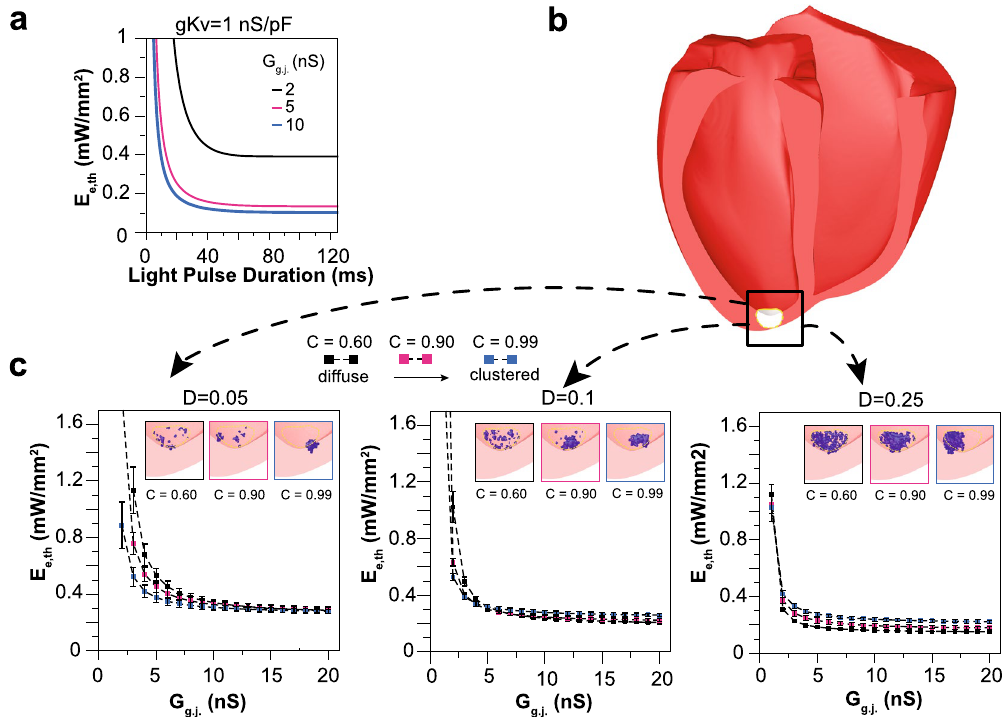
Figure 4. OptoGap applicability to arbitrary cell arrangements in the three-dimensional tissue setting. ( a ) Cellular model of a CM coupled to five ChR2-cFB indicates decreasing E e,th as a function of coupling and pulse duration, as seen in Fig. 3 and as expanded upon in Suppl. Figure 4. ( b ) Schematic of a human heart in which a region at the apex of the left ventricular epicardium (white-coloured region) was infused with ChR2-cFBs coupled to native CMs at different densities (D) and rates of spatial clustering (C). ( c ) Three levels of donor cell density (left to right) were examined. For each value of D, computationally-derived E e,th faithfully reports heterocellular coupling despite very different spatial patterns resulting from variability in C. n = 5 for each combination of D and C parameters, mean ± SE; all individual data points are shown in Suppl. Figure